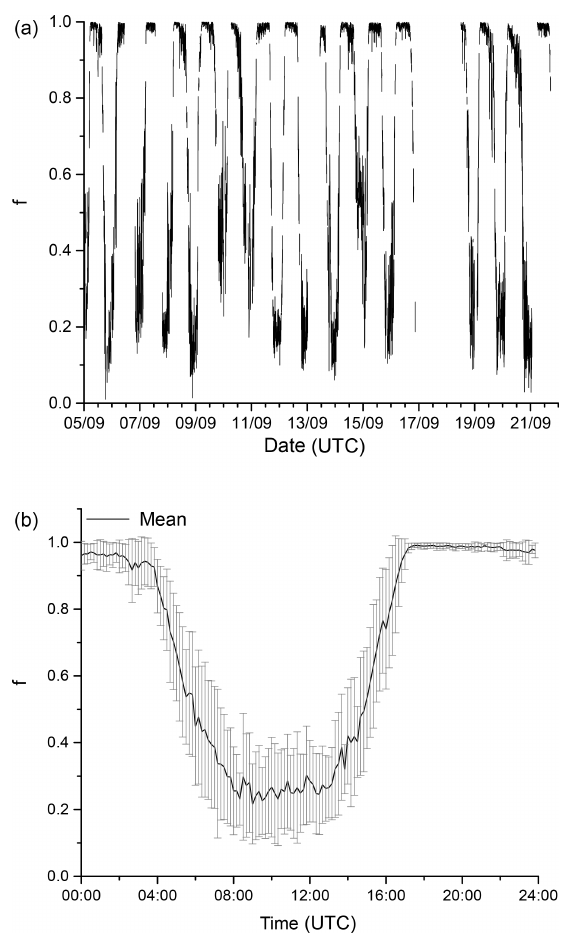
Figure 12. The fraction, f , of the total NO 3 loss with organic trace gases as a time series (a) and as a campaign averaged, diel cycle (b) where f = k OTG /(k OTG + J NO